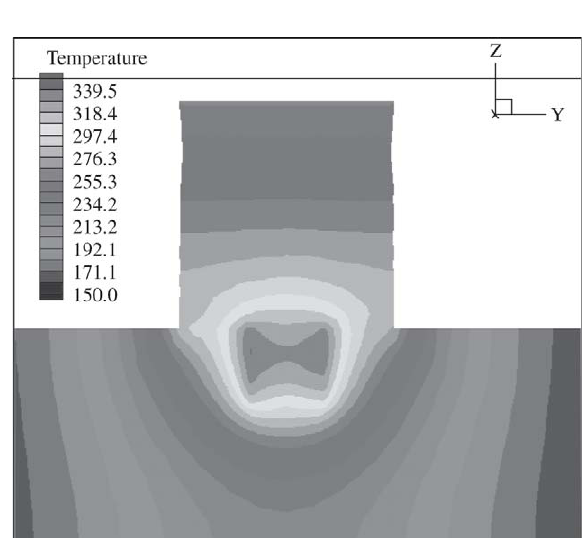
Figure 5. Material velocities and temperatures field respectively.